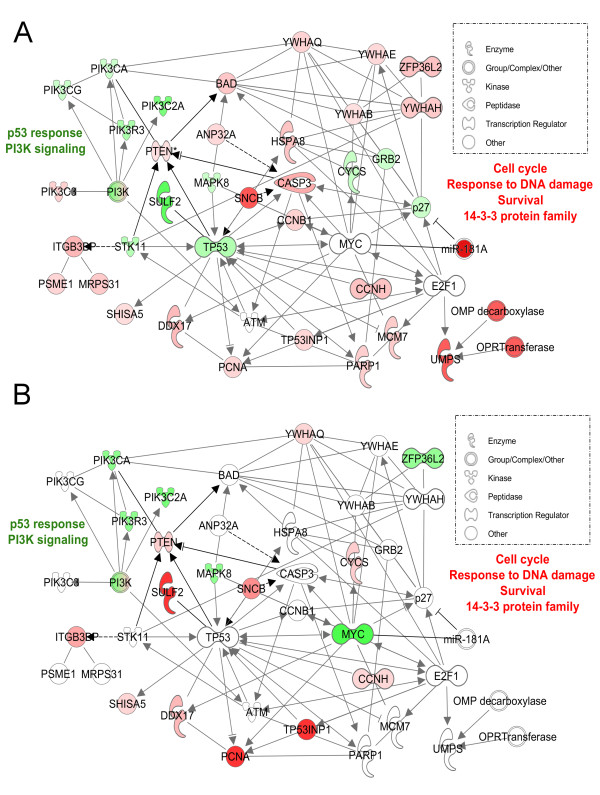
Molecular interaction network of fludarabine-regulated genes in cells of resistant CLL patients in vivo. A group of genes highly regulated by fludarabine in resistant patients (following a 24h exposure in vivo) was clustered in a network around the transcription regulators TP53 and MYC using the Ingenuity Pathway Analysis software (IPA 8.0, database Nov 2009). A. Gene expression values obtained from resistant patients were overlaid on the network. B. Gene expression values obtained from sensitive patients were overlaid on the network.